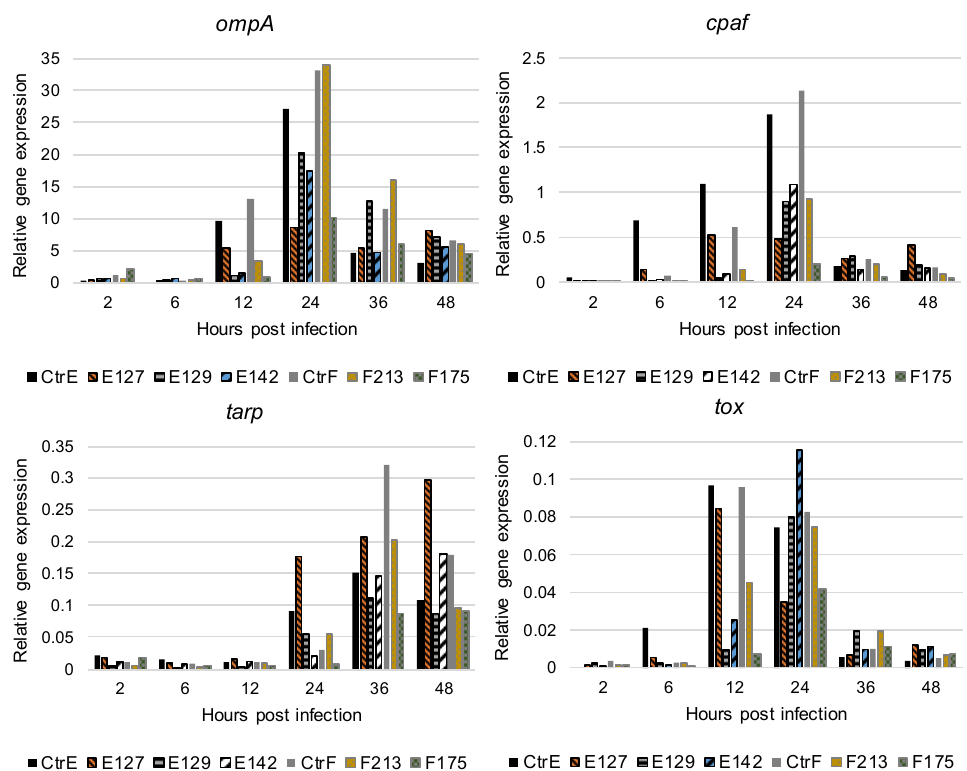
Figure 2. The expression of the ompA , cpaf , tarp , and tox genes of C. trachomatis reference strain type F213, and F175) at 2, 6, 12, 24, 36, and 48 hours post infection in HeLa229 cells. The results are based